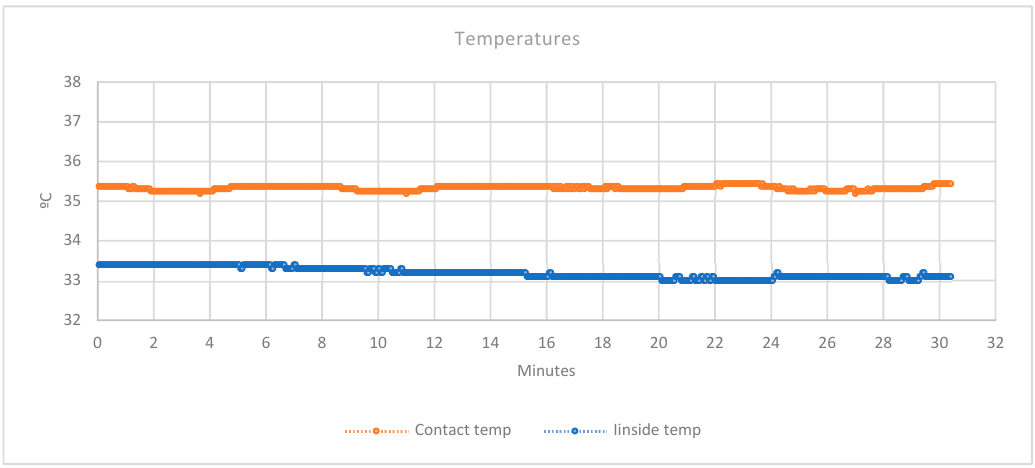
Figure 11. Temperatures graph.